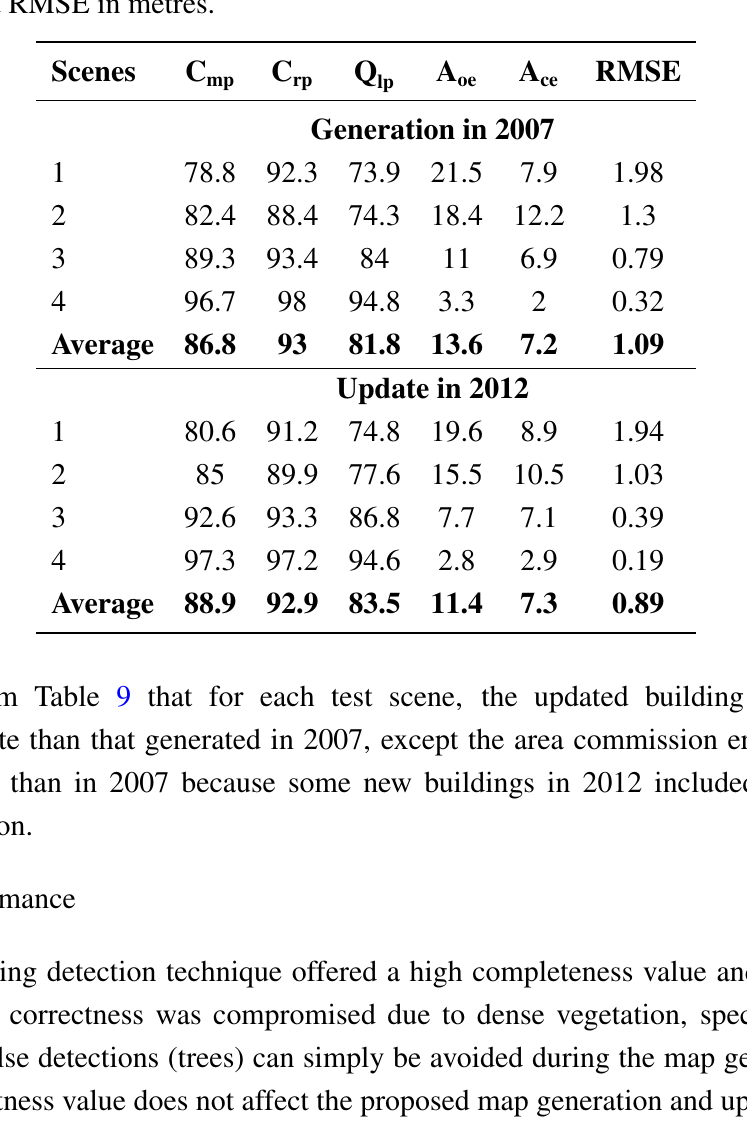
= completeness, mp = commission errors in ce